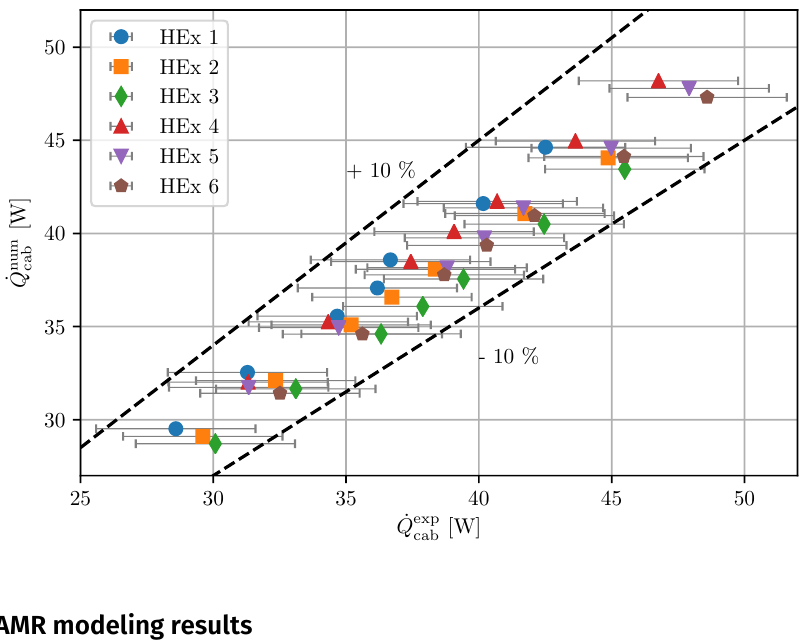
Figure 7. Steady-state cooling capacity (cabinet thermal load) predictions for the six heat exchanger-fan combinations. Note that the error bars represent an uncertainty of 3